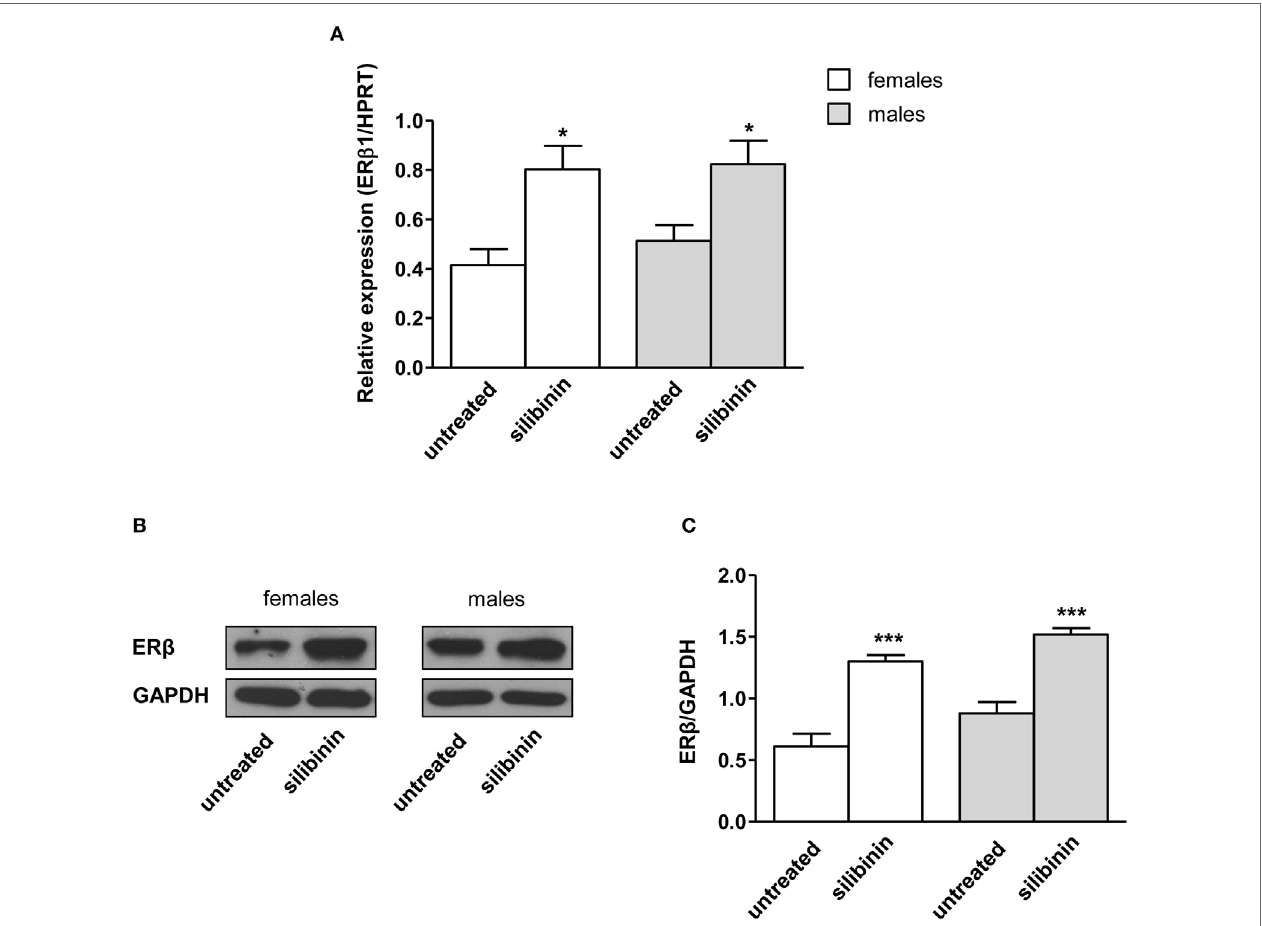
FigUre 1 | Silibinin increased the expression of estrogen receptor (ER) β in peripheral blood T lymphocytes from female and male healthy subjects. (a) ER β 1 mRNA levels were evaluated by quantitative real-time PCR after 24 h silibinin treatment. Data are expressed as ratios of the expression of ER β 1 and hypoxanthine-guanine phosphoribosyl transferase (HPRT) gene. Results are shown as mean ± SD from 10 randomly selected female and male healthy subjects. (b,c) ER β protein levels were also evaluated by Western blot analysis of T-cell lysates after 24 h silibinin treatment. Blots shown are representative of experiments performed in T cells from 10 randomly selected female and male healthy subjects (b) . Densitometry analysis of ER β levels relative to glyceraldehyde 3-phosphate dehydrogenase (GAPDH) is also shown. Values are expressed as mean ± SD (c) . * P < 0.05, *** P < 0.001 versus untreated